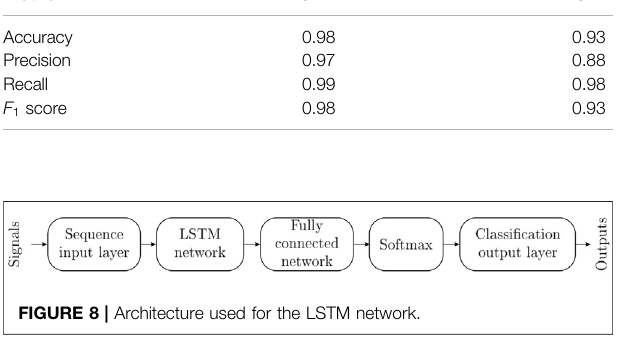
TABLE 2 | Performance index comparison between SVN and LSTM. Metric Accuracy